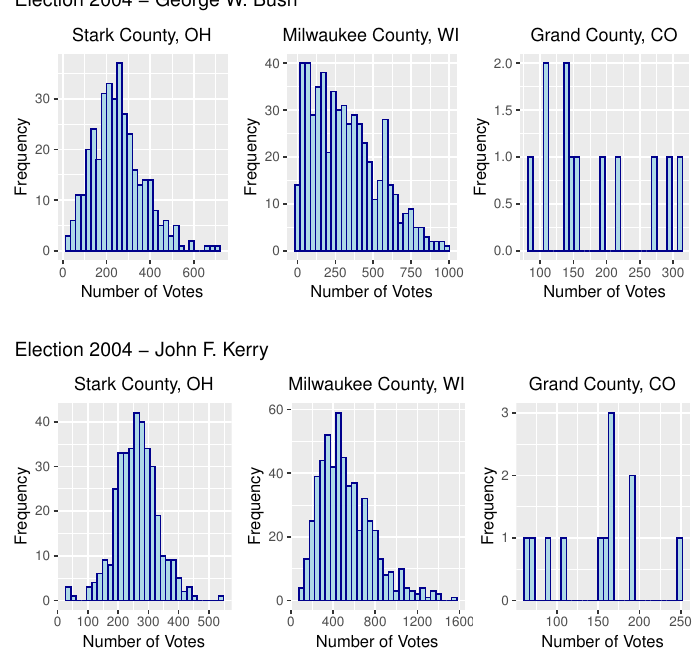
Figure 1. Vote Distributions Across Precincts in US 2004 Presidential Election for Selected